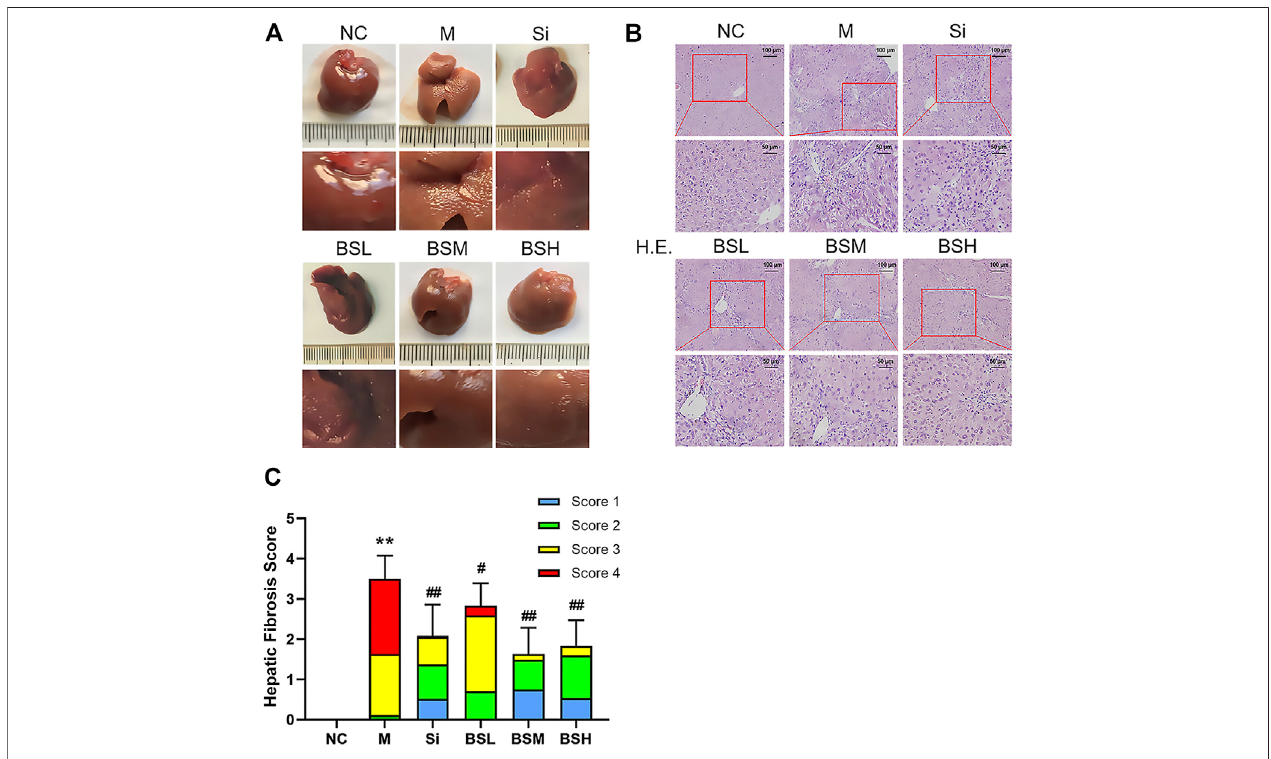
FIGURE 7 | BS improved the pathological characteristics in mouse liver fi brosis models. (A) The pathological changes of each group at the end of the experiment. (B) Representative liver sections of H&E staining; scale bars (cid:2) 100 μ m, 50 μ m as indicated. (C) Hepatic fi brosis scores were counted and compared. Data were shown as mean ± SD, n ≥ 3 and analyzed with the one-way ANOVA. ** p < 0.01 in the model group versus the control group. # p < 0.05, ## p < 0.01, Si, BSL, BSM, and BSH groups versus the model